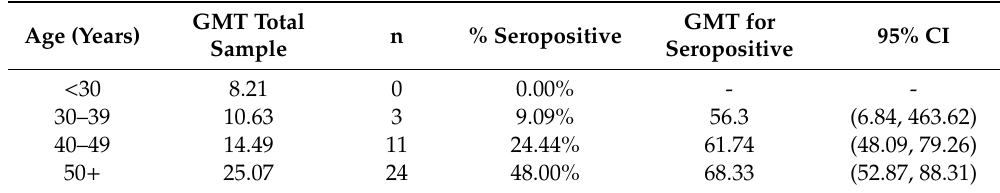
Figure 2. Geometric mean titres with 95% confidence interval (CI) for anti-vaccinia neutralising antibody by age group, including seronegative (horizontal line is the level considered seropositive, > 32). Table 1. Geometric mean titres (GMT) for anti-vaccinia neutralising antibody by age group for the total sample and restricted to the people considered seropositive (titre ≥ 32), with 95% confidence interval (CI).